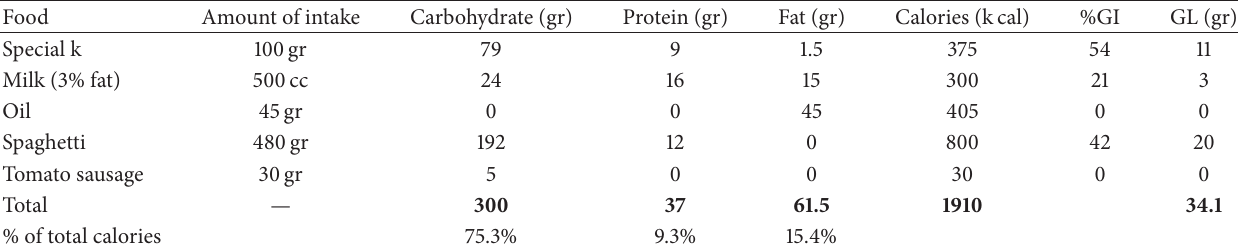
Table 1: Details and ingredients of consumed foods in 24-hour LGI period.